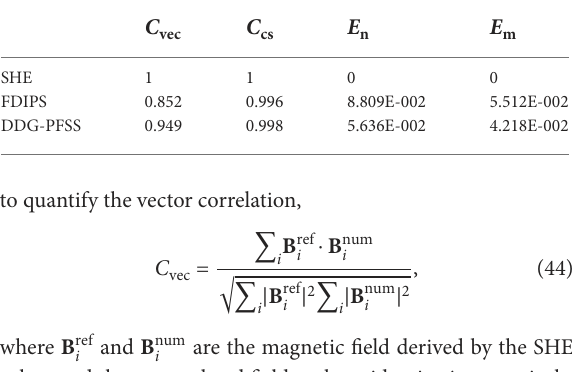
TABLE 2 C vec , C cs , E n and E m for the extrapolated fields of the FDIPS and DDG-PFSS